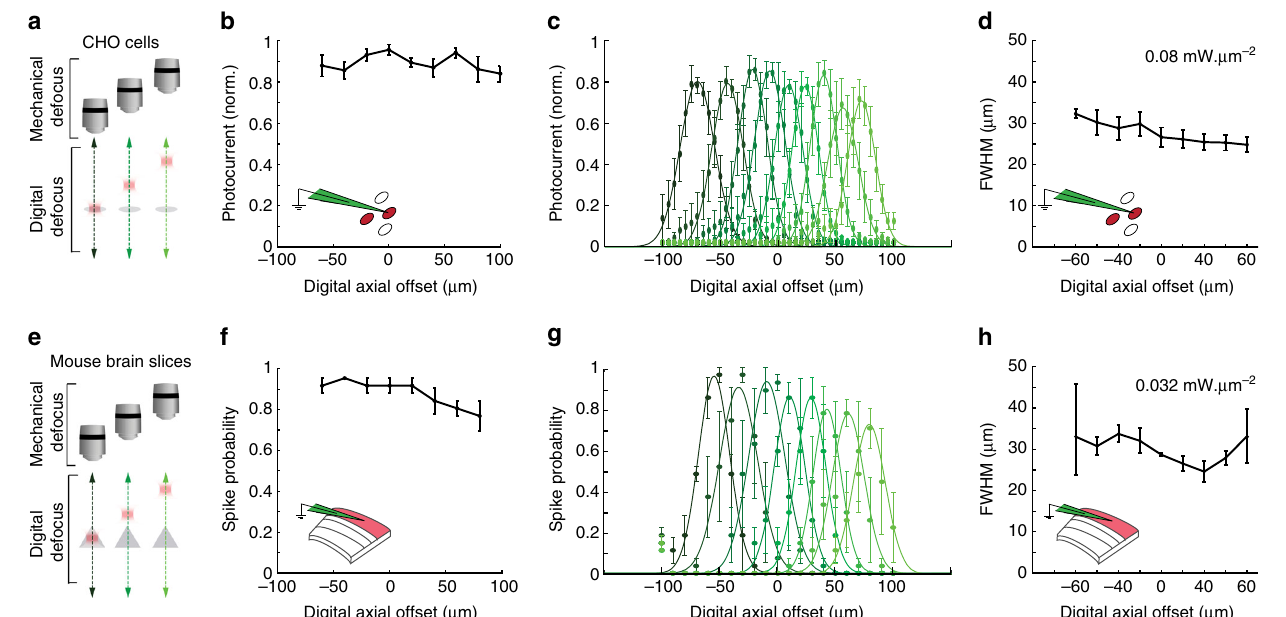
Fig. 5 3D-SHOT provides cellular resolution photostimulation in a large volume through digital focusing. a To quantify the spatial resolution of 3D-SHOT as a function of hologram target depth, we recorded photocurrents in CHO cells while digitally targeting varying positions along the optical axis ( z ), and measuring resolution by mechanically sweeping the objective over the entire ( z ) range and measuring the response at each point. b Normalized photocurrent in CHO cells while targeting the same cell from different axial displacements ( n = 5 cells; p = 0.39, Kruskal − Wallis test with multiple comparisons correction, data are mean and s.e.m.). c Axial photocurrent resolution as a function of digital displacement — shaded green colors denote mechanical sweeps across the optical axis for different digital displacements. d Quanti fi cation of the FWHM for the axial fi t of photocurrents in CHO cells as a function of digital defocus from the focal plane ( n = 5 cells, p = 0.07, data are mean and s.e.m.). e − h As in a − d , but spike probability recorded in mouse brain slices via current clamp instead of photocurrent in CHO cells recorded in voltage clamp ( f : p = 0.2; h : p = 0.17, n = 3